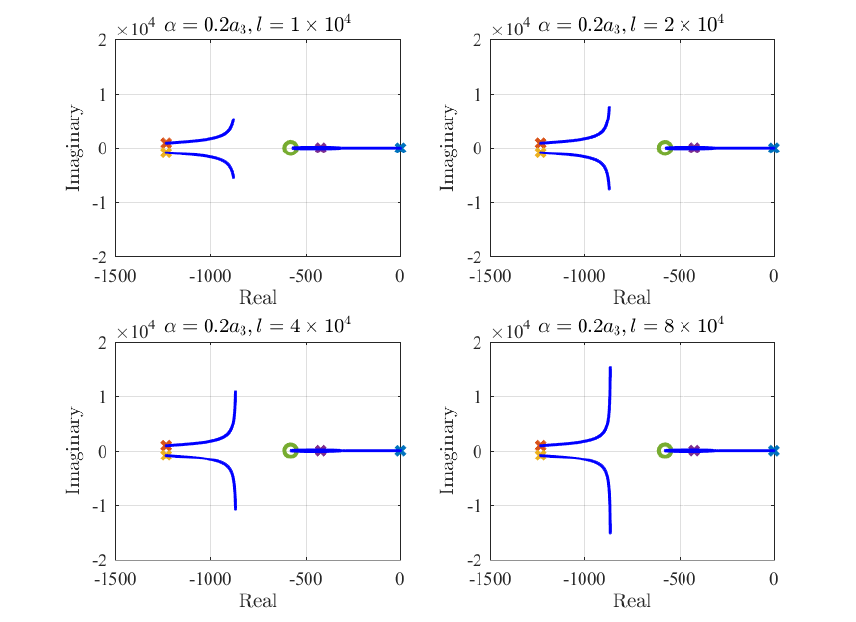
Figure 9. Root trajectories of ROPIO compensated ROMBC by increasing l with α = 0.2 a 3 .